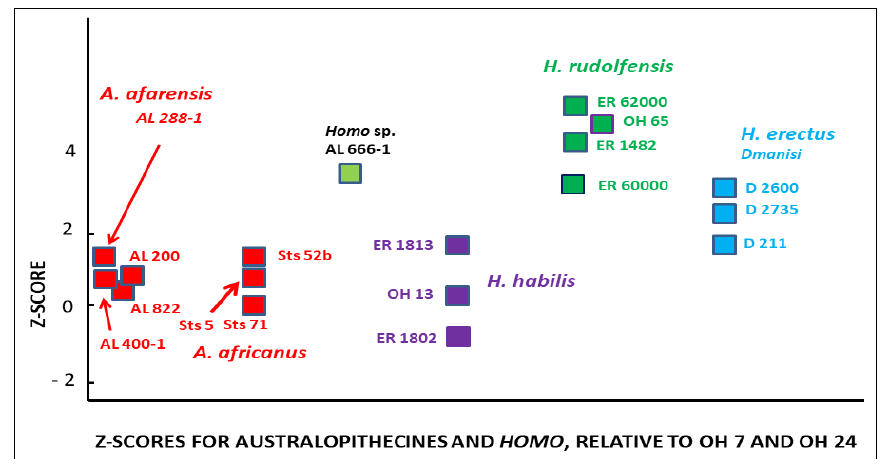
Figure 2: Visualisation of Z-scores for hominins based on data in Table 1. OH 7 and OH 24 are the reference specimens for pairwise comparisons with other